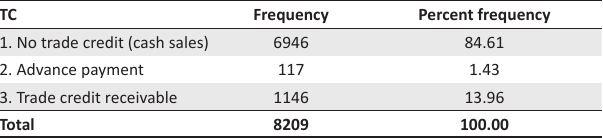
Table 4. The Pearson chi-square statistic is asymptotically TABLE 3: Trade credit activity among smallholder farmers. TC